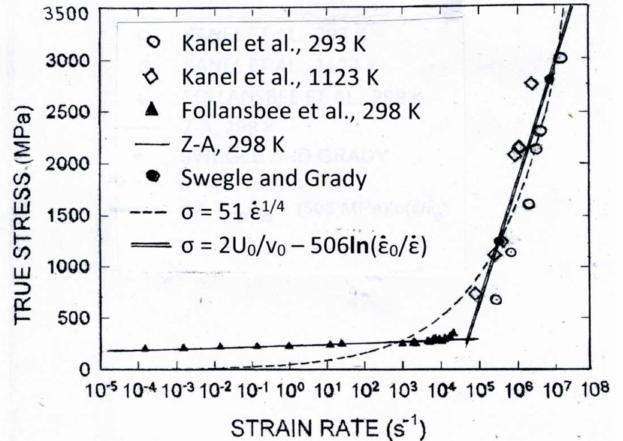
Figure 5. Temperature-dependent increase in shock-induced flow stresses obtained for annealed copper plate impact tests [20], as compared with Swegle and Grady plate impact measurements [5] and, at lower stresses, SHPB measurements of Follansbee et al. [1] fitted with a Z-A type fcc crystal constitutive relationship